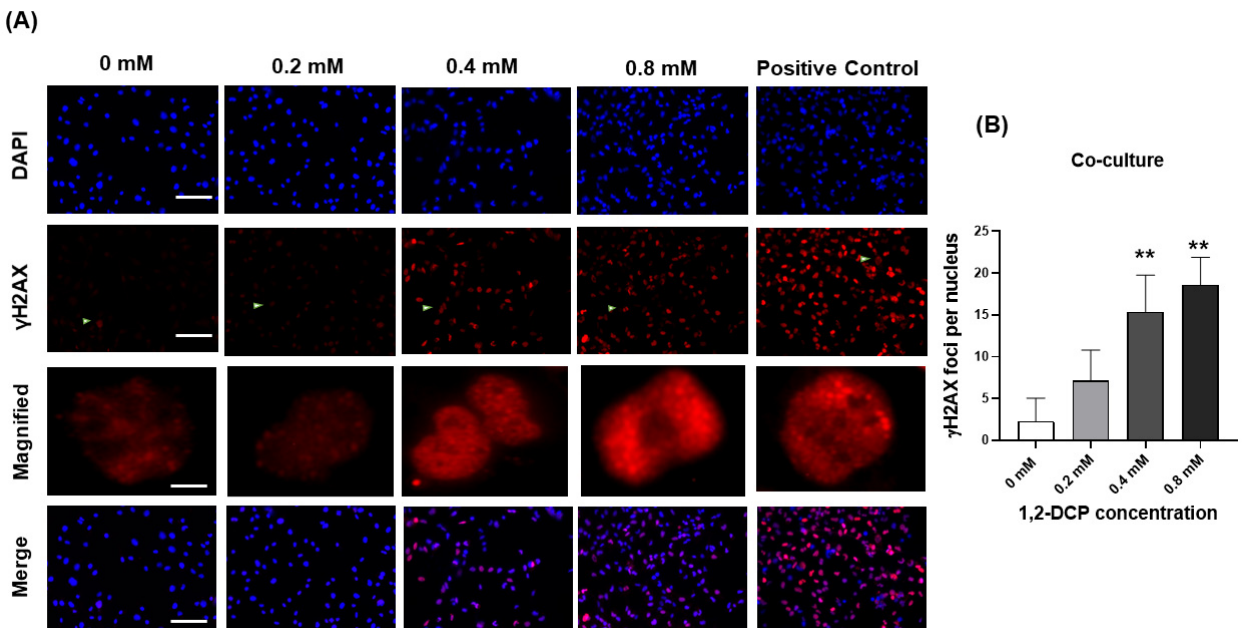
Figure 5. Effects of 1,2-DCP on DNA in MMNK-1 cholangiocytes co-cultured with THP-1 macrophages, as assessed by γ H2AX immunocytochemistry. Co-cultures of MMNK-1 cholangiocytes and THP-1 macrophages were exposed to 1,2-DCP at 0, 0.2, 0.4, and 0.8 mM for 24 h. Positive control MMNK-1 cholangiocytes were exposed to 0.2 mM of H 2 O 2 for 2 h. MMNK-1 cholangiocytes were fixed with 4% PFA, permeabilized with 0.2% Triton-X, blocked with 1% BSA in PBST, and incubated with primary anti- γ -H2AX antibody overnight, then with secondary antibody. Nuclei were stained with DAPI and examined by fluorescence microscopy. Scale bar: 100 µ m for all images except the magnified images (20 µ m). Arrowheads: magnified images. ( A ) Photomicrographs of γ H2AX immunostaining. ( B ) γ H2AX foci count per nucleus. Data are mean ± SD, n = 3., ** p < 0.01, compared with the control group (0 mM), by one-way ANOVA followed by Dunnett’s multiple comparison